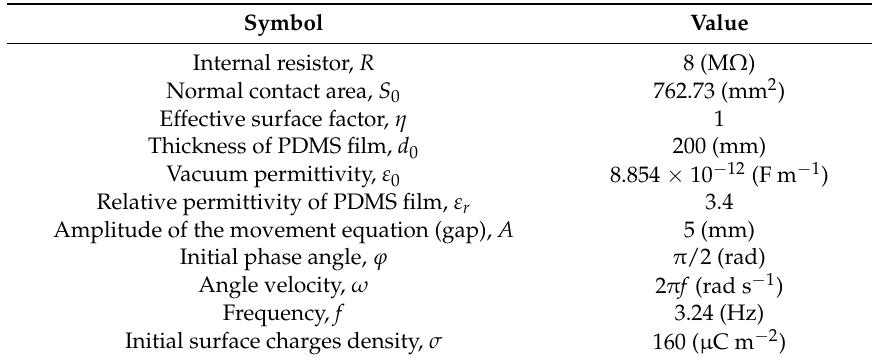
Table 2. Theoretical analysis parameters.